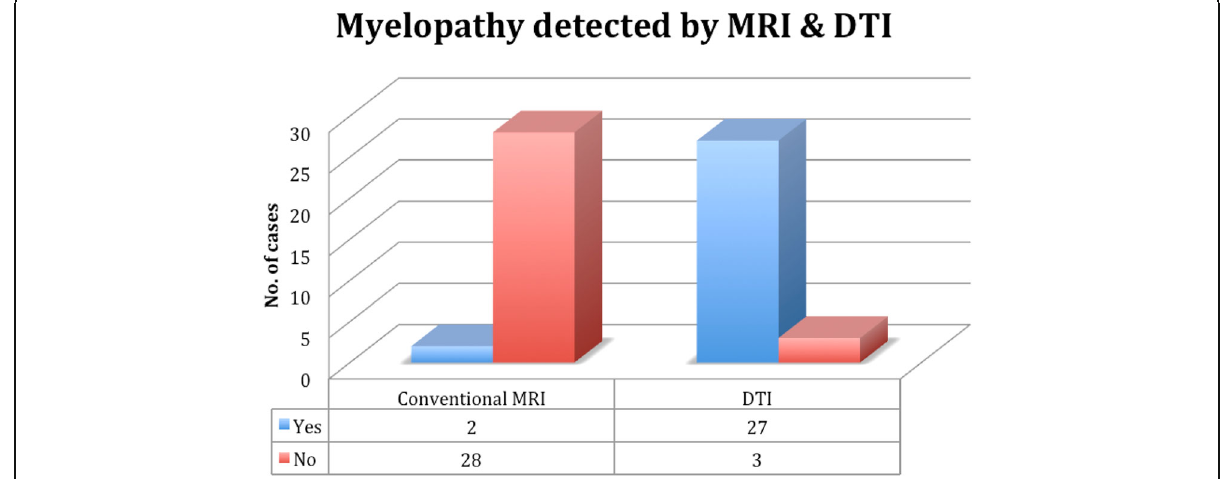
Fig. 1 Distribution of cases according to myelopathy detected with conventional MRI and DTI. DTI found to be 93% more sensitive in detecting early myelopathic changes than the conventional